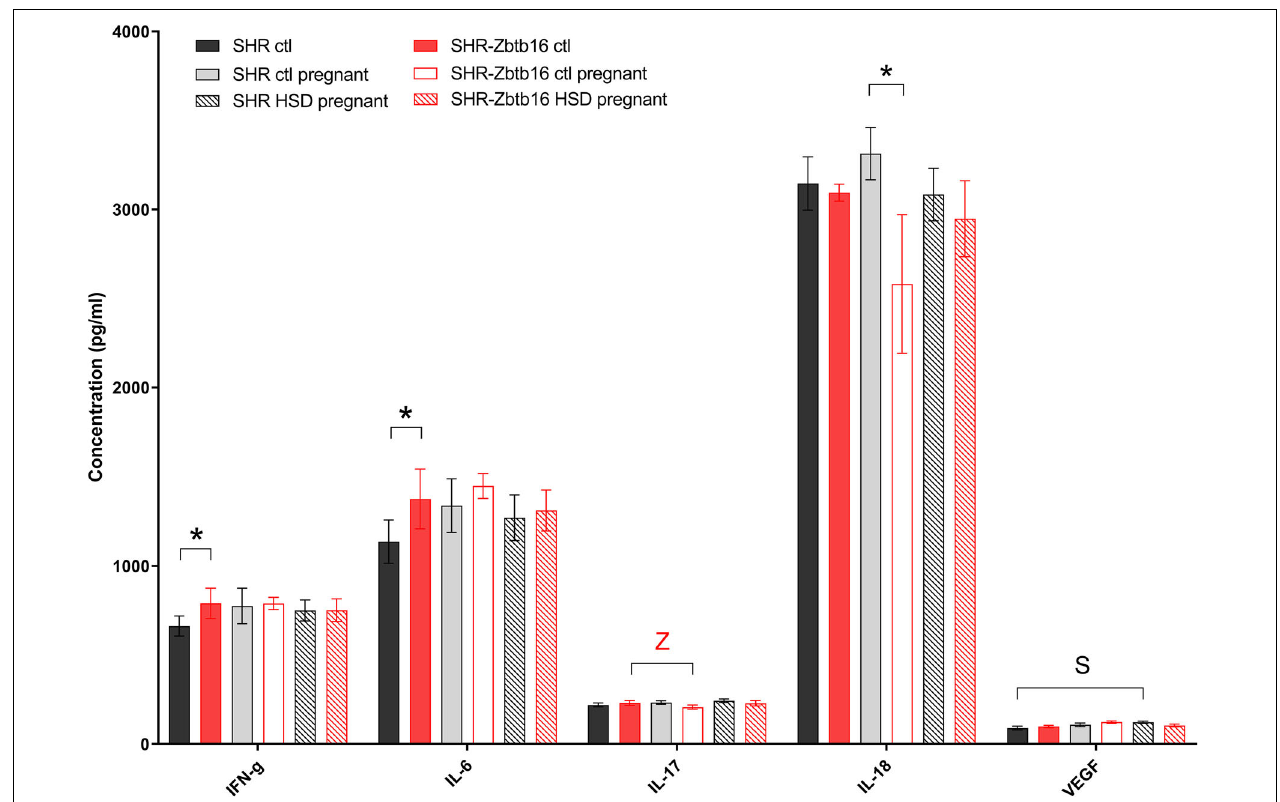
FIGURE 6 | Cytokine profile. Cytokine concentrations in the serum of SHR female rats fed standard diet before pregnancy (SHR ctl: black bars, SHR- Zbtb16 ctl: red bars), standard diet in pregnancy (SHR ctl pregnant: light gray bars, SHR- Zbtb16 ctl pregnant: empty red bars), HSD in pregnancy (SHR HSD pregnant: black patterned bars, SHR- Zbtb16 HSD pregnant: red patterned bars). Within the graph, the significance levels of pair-wise group comparison (ctl vs. ctl pregnant vs. HSD pregnant) by post-hoc Fisher’s test of the two-way ANOVA with STRAIN and DIET as major factors are indicated as follows: * p < 0.05. Data are expressed as mean ± SEM. S represents differences in SHR: VEGF ∗ between SHR ctl and SHR HSD pregnant. Z represents differences in SHR- Zbtb16 : IL-17 ∗ between SHR- Zbtb16 ctl and SHR- Zbtb16 ctl